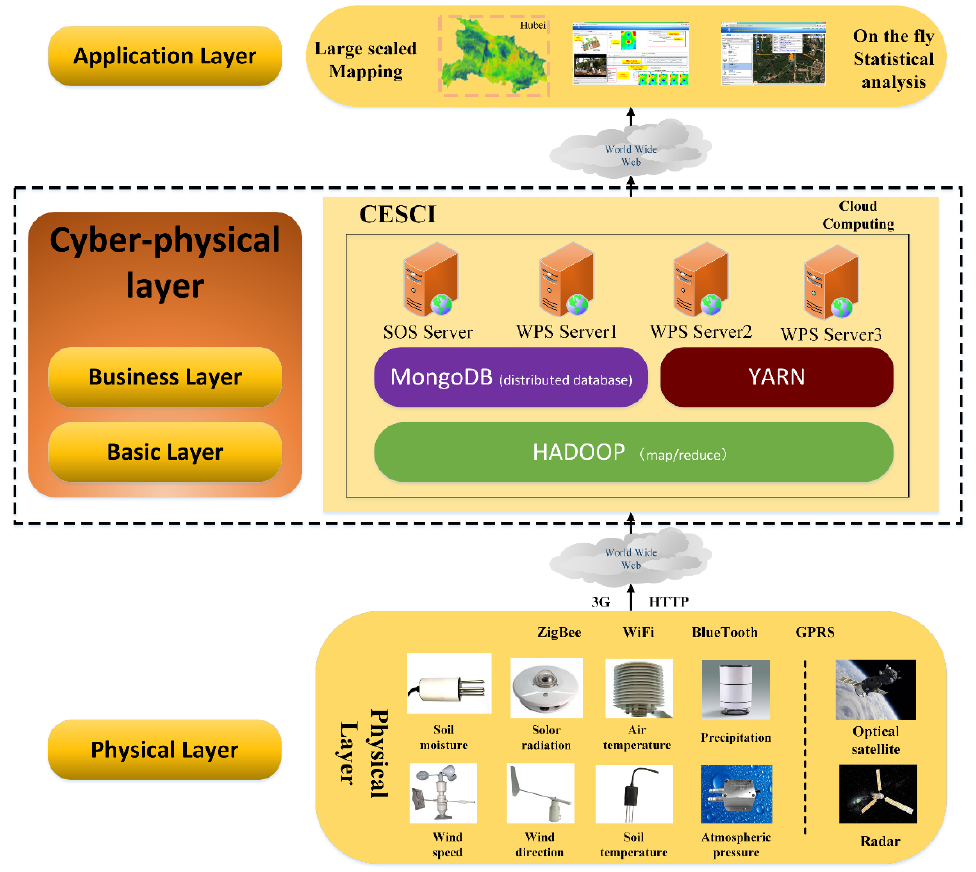
Figure 1. Architecture of the cloud computing-enabled spatio-temporal cyber-physical information infrastructure.